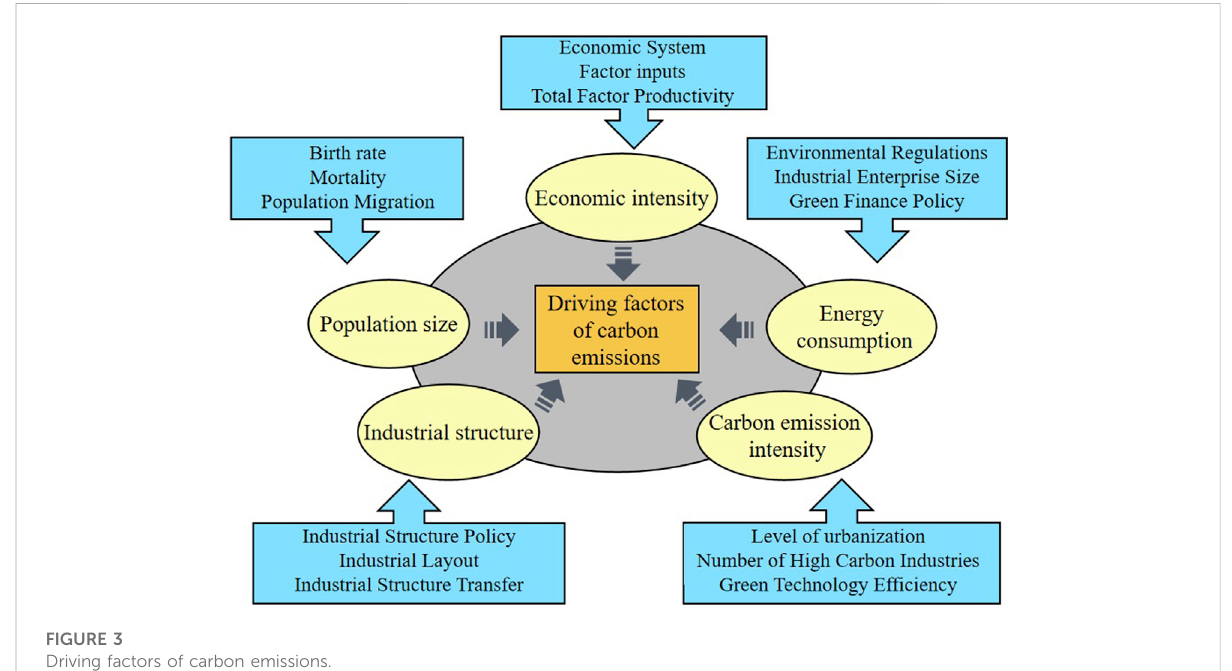
FIGURE 3 Driving factors of carbon